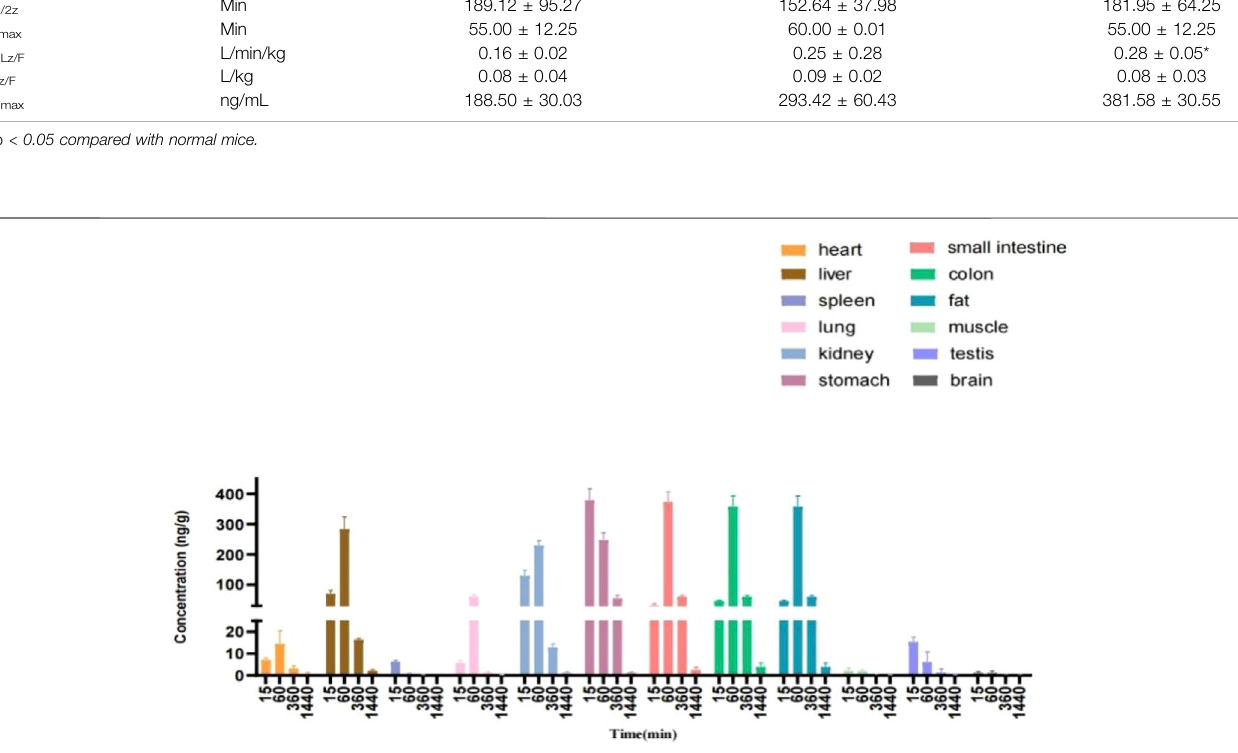
Frontiers in Chemistry |